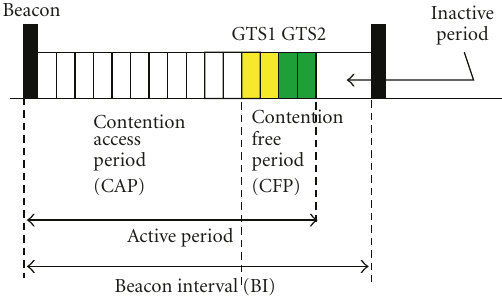
Figure 15: SuperFrame Structure in the IEEE 802.15.4 standard. In beacon enabled mode, the beacon interval can be subdivided into a Contention Access Period (CAP) and eventually into a Contention Free Period (CFP) and Inactive